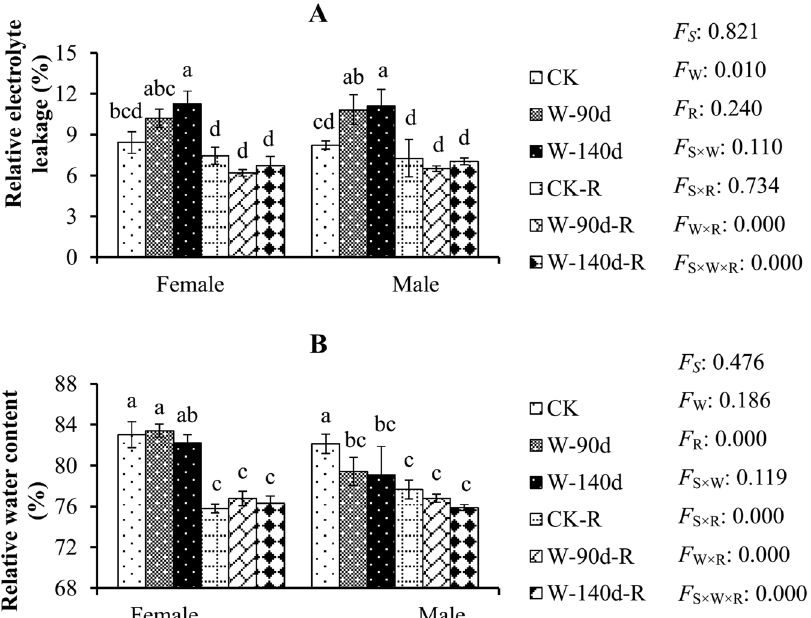
Figure 2. Maximum efficiency of PSII ( Fv/Fm ), effective quantum yield of PSII ( Yield ), photosynthetic electron transportation rate (ETR ), photochemical quenching coefficient ( qP ), and non-photochemical quenching coefficient ( qN ) in male and female P. deltoides under winter flooding stress and post-flooding recovery. CK, control treatment; W, flooding and waterlogging stress treatment; R, recovery after waterlogging stress. Values are means ± SE ( n = 5). Letters above the columns indicate significantly differences at P < 0.05 according to Duncan’s test. The significance values of the factorial analysis (ANOVA) for: F S , F W , and F R refer different effects of species, watering, and recovery growth, respectively; F S × W , F S × R , F W × R , and F S × W × R refer species × watering effects, species × recovery growth effects, watering × recovery growth effects, and species × watering × recovery growth effects,